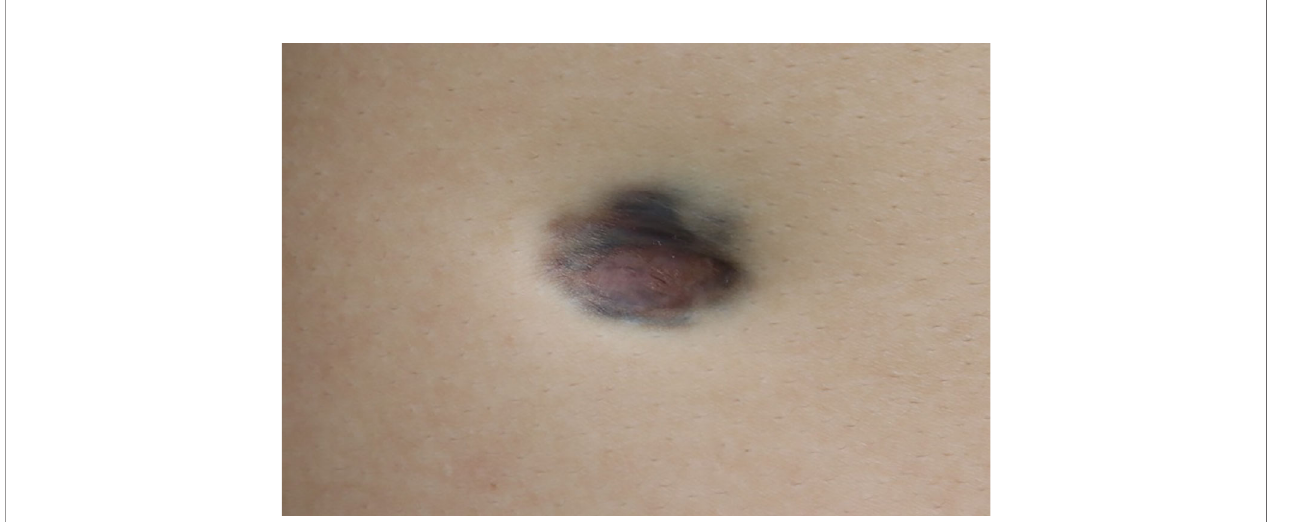
FIGURE 1 | Bluish-black plaque with central atrophy on the left back of the